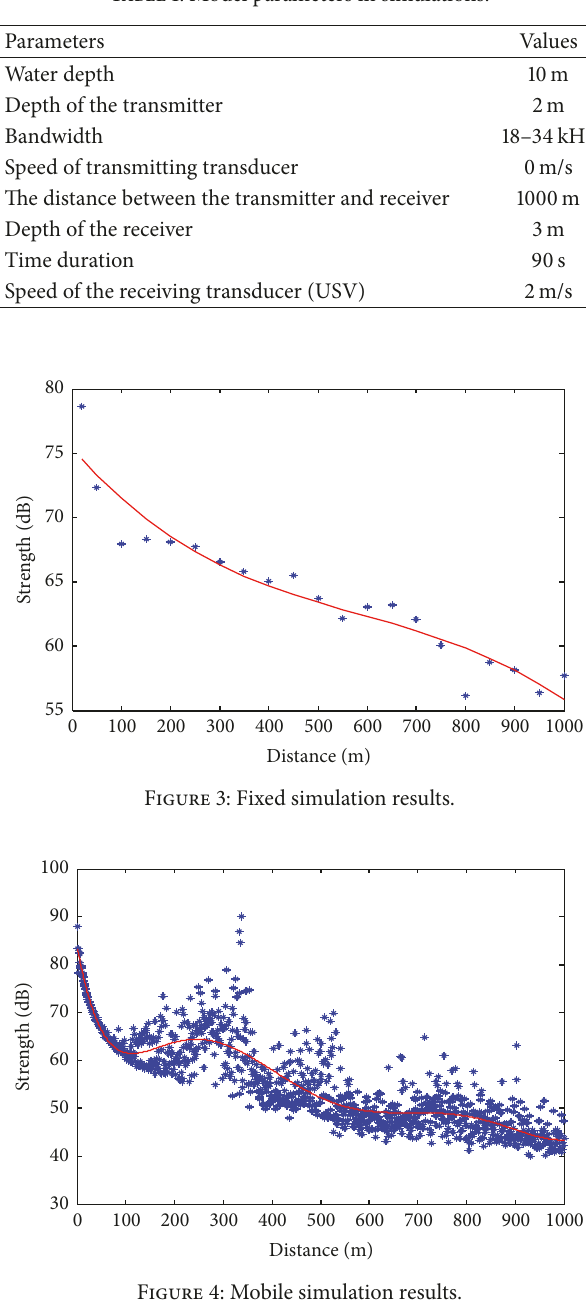
Table 1: Model parameters in simulations.